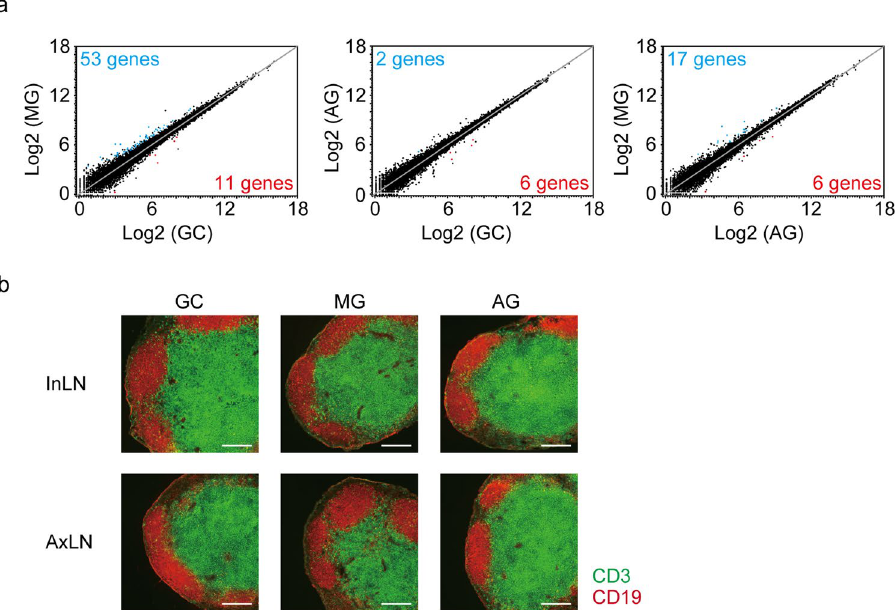
Figure 5. Minimal influences on gene expression and structure of lymph nodes by spaceflight. ( a ) Scatter plots of RNA-Seq data. Each axis shows log2 of average gene expression values, which were normalized using the CLC Main Workbench (Qiagen). GC: ground control mice; MG: mice flown in the ISS; AG: mice receiving 1 g by centrifugation in the ISS. Significantly up- and down-regulated genes (FDR p-value < 0.05 and fold change >± 2 estimated using the EDGE test) are indicated as red and blue dots, respectively. ( b ) Immunostaining of inguinal (upper) and axillary (lower) lymph nodes with anti-CD3 (green) and anti-CD19 (red). Scale bars indicate 200 µ m. Data represent a typical example of three independent mouse